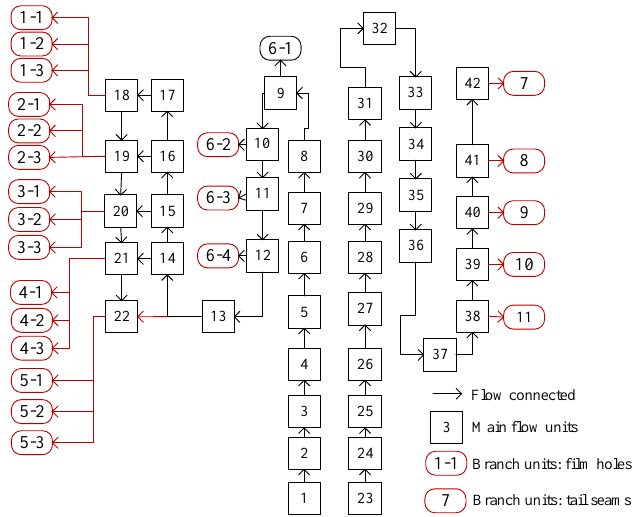
Figure 24. The connection relationships between the flow units of